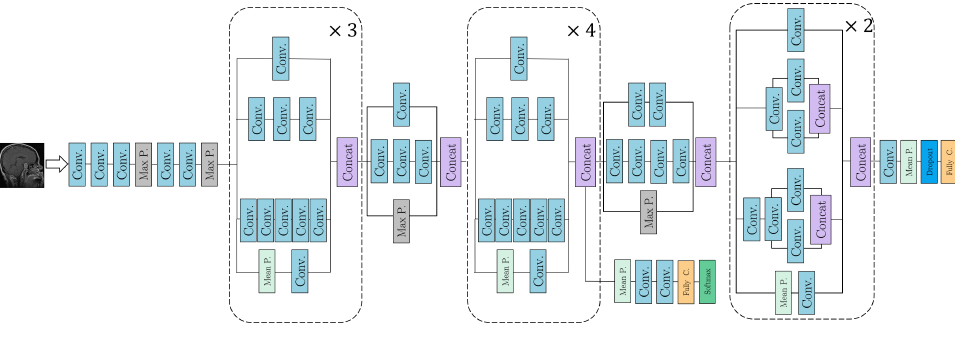
Figure 5. A basic representation of pre-trained InceptionV3 architecture.